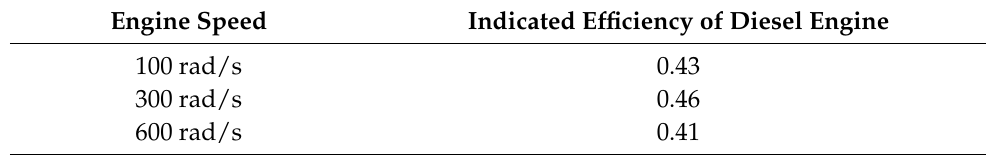
Table 2. Typical indicated efficiency values of diesel engines as a function of speed